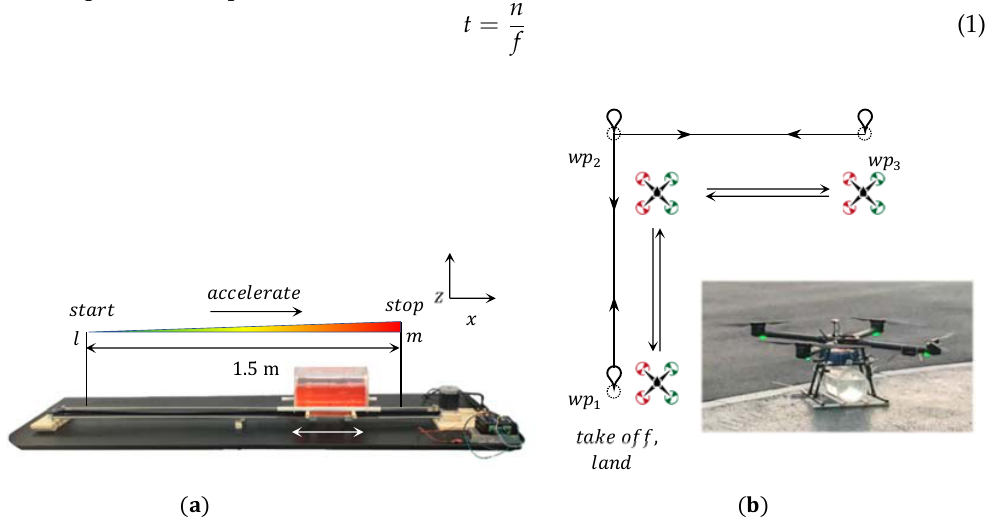
Figure 8. Experiment methods: ( a ) slosh-effect test using the tank and linear slider and ( b ) flight-path mission of UAV experiment.